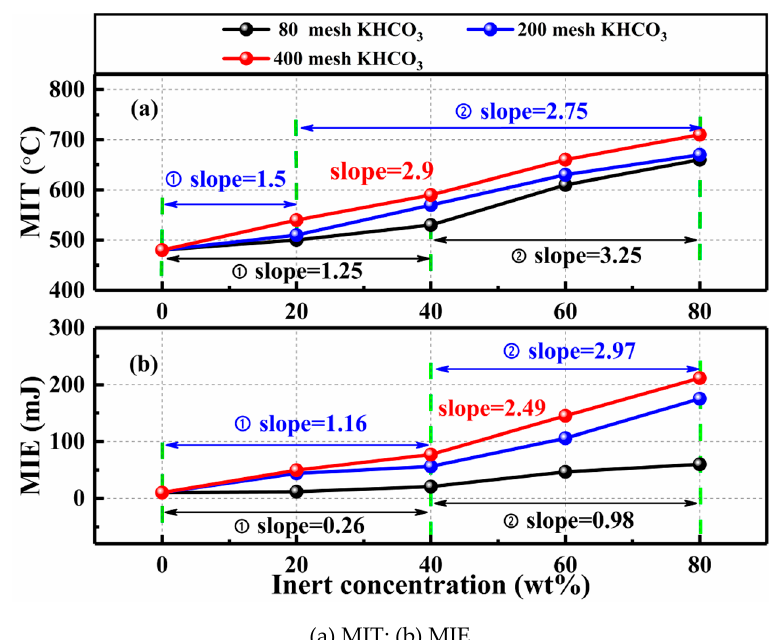
Figure 6. Effect of KHCO 3 powder of three particle sizes on the MIT and MIE of PE. Figure 6. E ff ect of KHCO 3 powder of three particle sizes on the MIT and MIE of